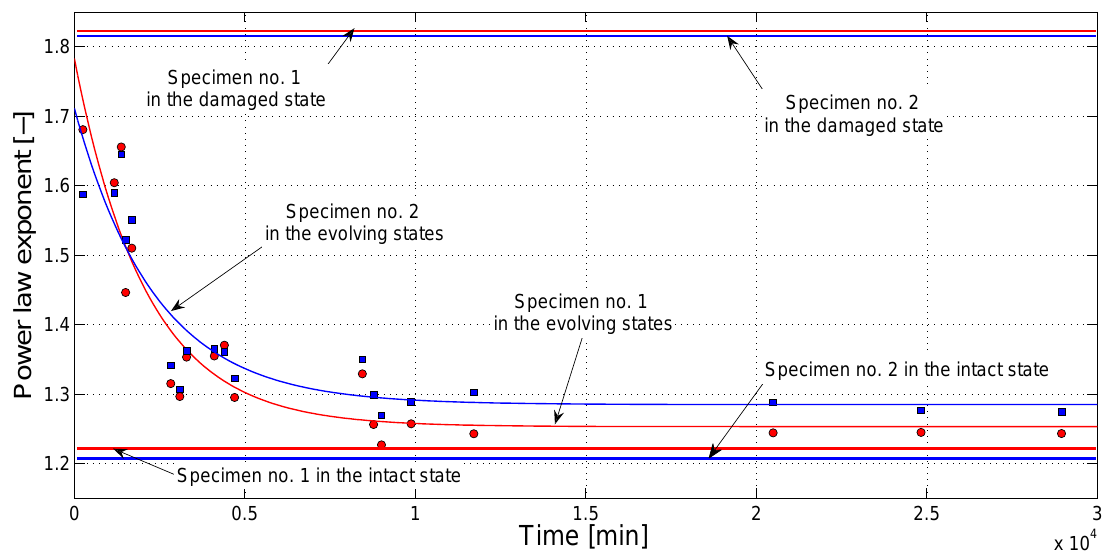
Figure 10. Time evolution of the exponent of the power-law fitting used to interpolate the y versus x data from SSM